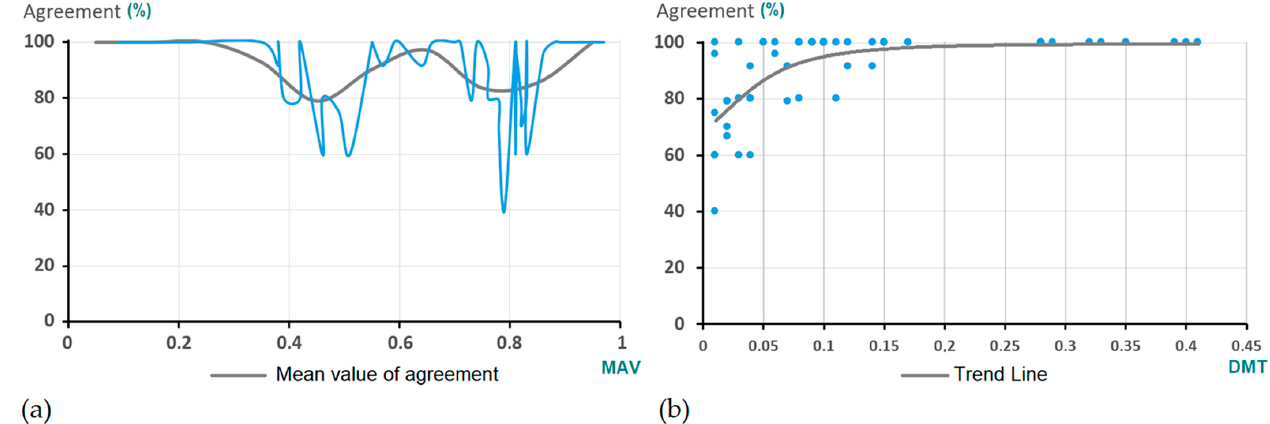
Figure 11. Uncertainty around threshold values; ( a ) level of agreement according to the MAV; ( b ) agreement according to the distance to the MAV threshold.